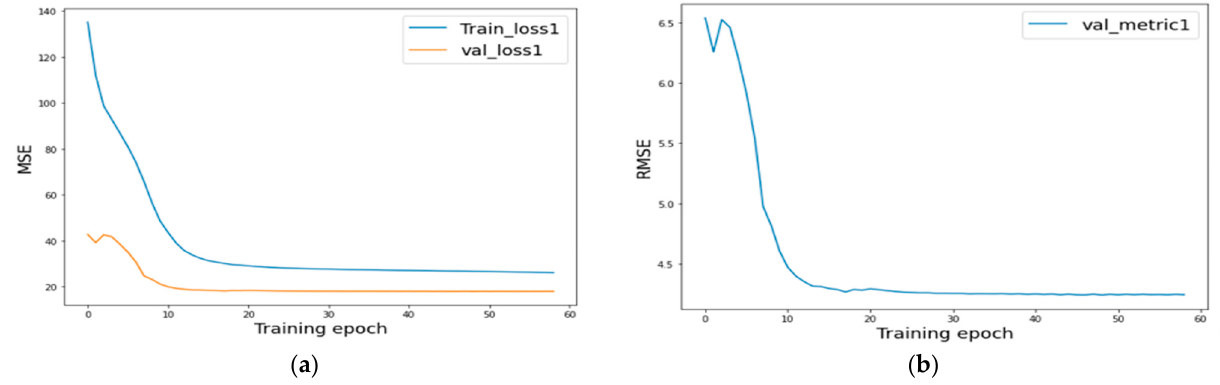
Figure 15. ( a ) Loss function reductions (MSE) (training and validation); ( b ) validation metric (RMSE).